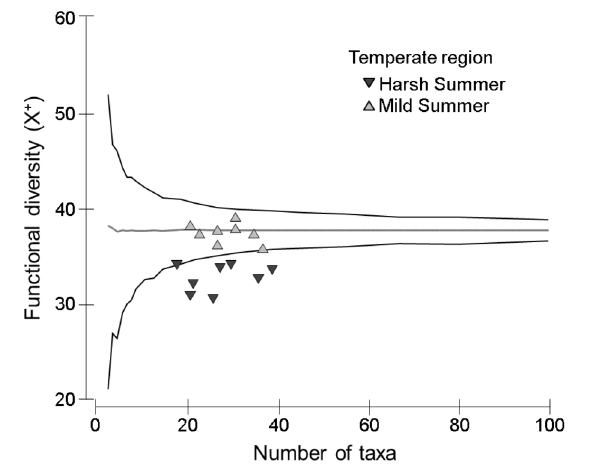
Figure 3. Functional diversity trends vs. taxonomic richness in the Temperate wetlands of the case study. communities observed over a complete hydroperiod in Harsh Summer Temperate wetlands (dark symbols) and Mild Summer Temperate wetlands (light symbols) were plotted against a 95% probability funnel using the TAXDTEST routine. Whereas wetlands within this funnel host communities with traits that could be explained as random draws from the pool (null hypothesis, H below the 95% probability threshold present a significantly lower functional diversity than would be expected according to taxonomic richness (H A2